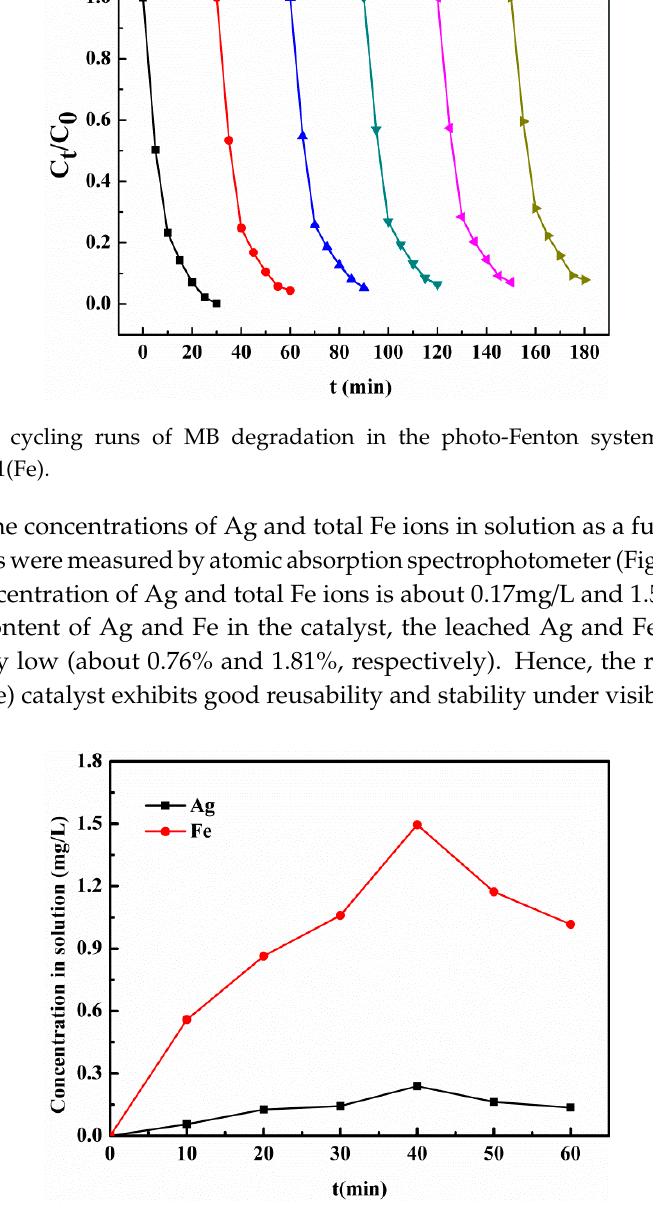
Figure 13. The concentrations of Ag and total Fe ions in solution as a function of time in the photo-Fenton process.